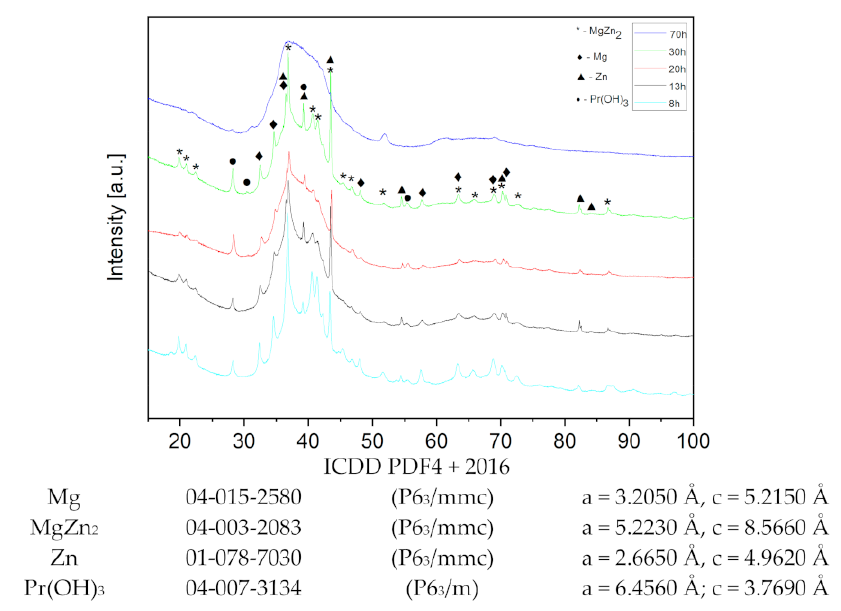
Figure 2. Phase analysis of the Mg-Zn-Ca-Pr alloy powders milled for 8, 13, 20, 30, and 70